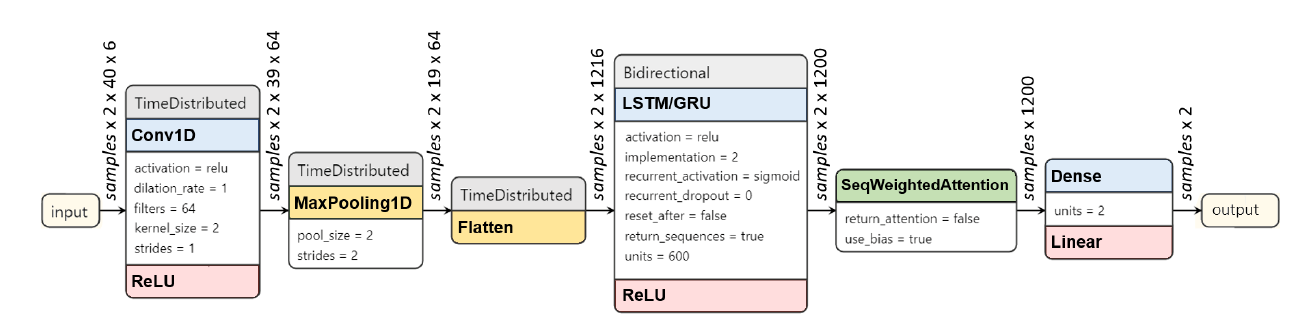
Figure 5. The parameters and data dimensions for each layer of CNN-GRU/LSTM Attention model.